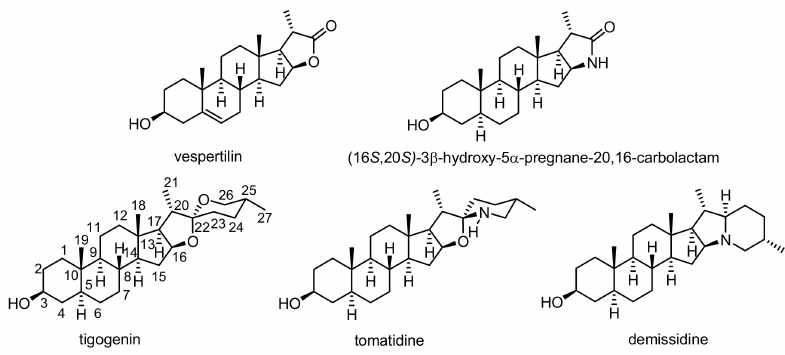
Figure 1. Vespertilin, the target lactam, tigogenin, and steroidal